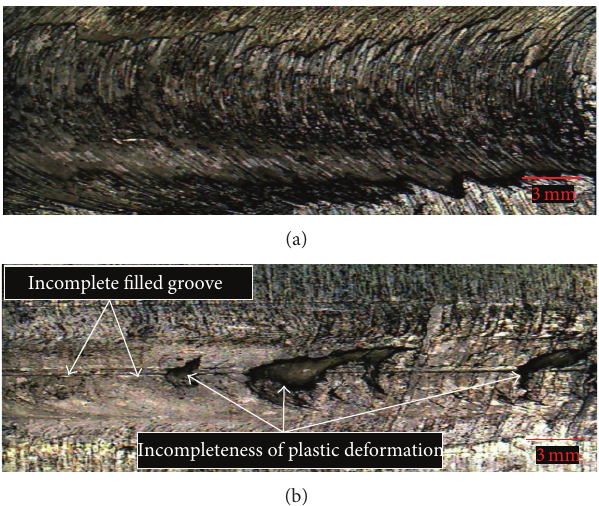
Figure 5: The weld profile of the Al-Al friction stir welded joints at a rotational speed of 1750 rpm and traverse speed of 45 mm/min at (a) the top side and (b) the bottom side.